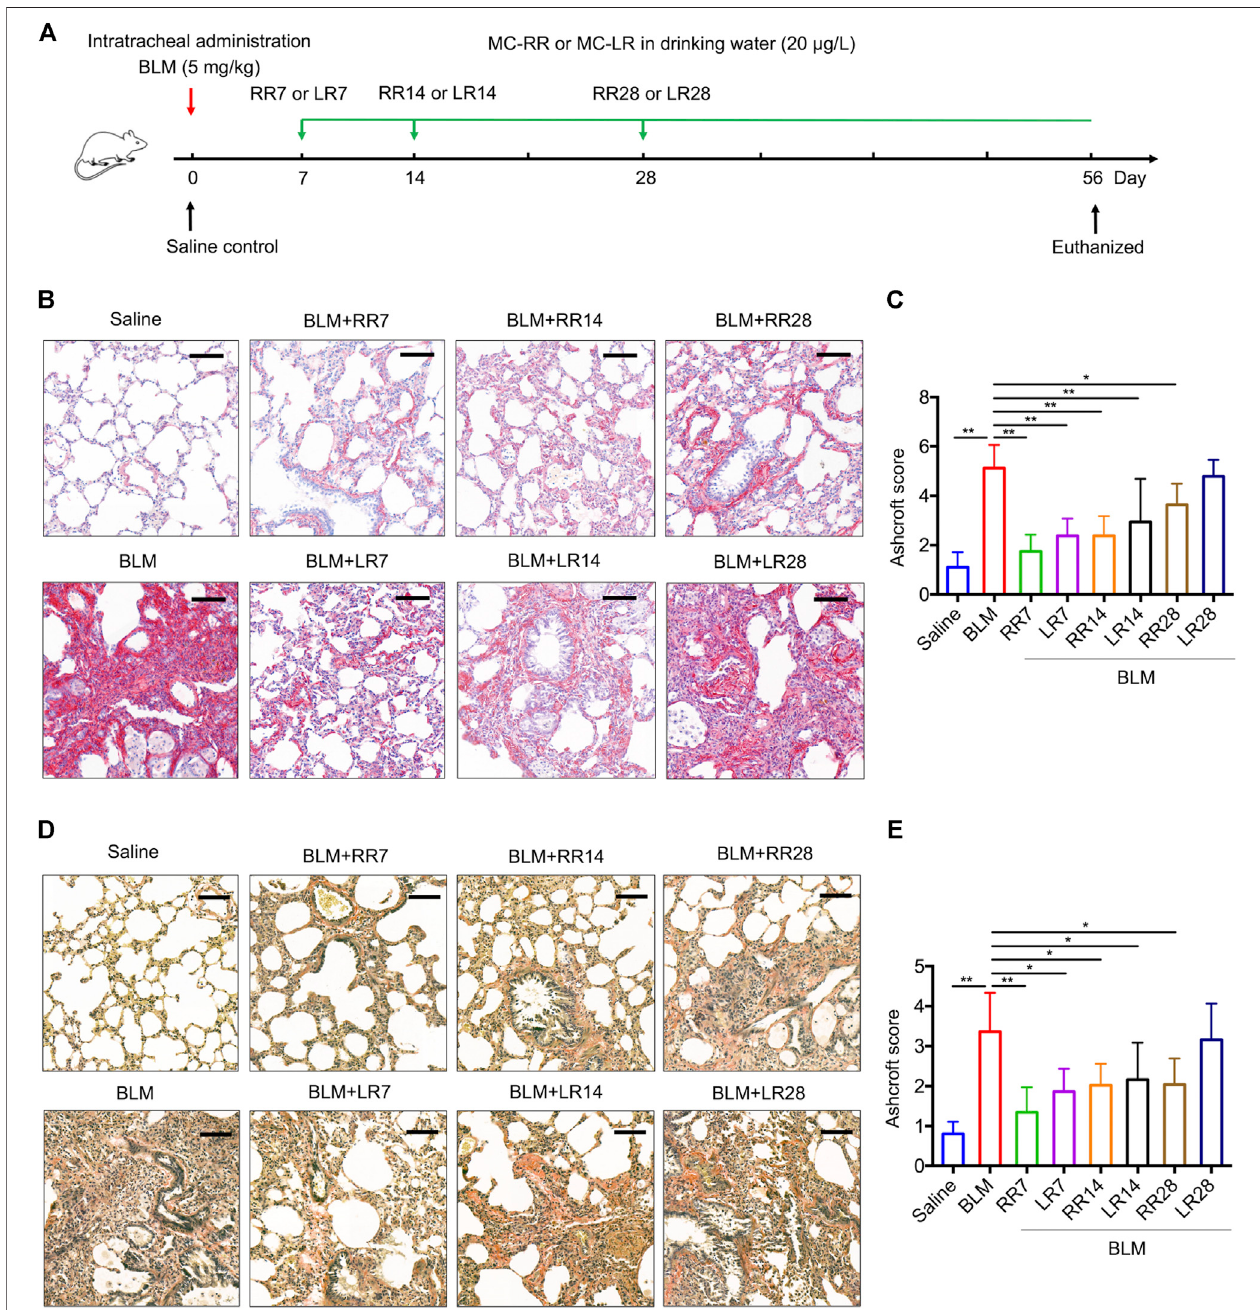
FIGURE 3 | Microcystin-RR (MC-RR) inhibits deposition of collagen and elastic fi bers better than Microcystin-LR (MC-LR). Rats were intratracheally instilled with a single dose of bleomycin (BLM, 5.0 mg/kg) on day 0 and started to receive MC-RR or MC-LR (20 μ g/L) in drinking water on day 7 (LR7/RR7), 14 (LR14/RR14), or 28 (LR28/RR28). On day 56, rats were killed and their lung tissues were collected for analysis. (A) Schematic representation of the experimental design. (B,C) Lung tissue sections were prepared and subjected to Sirius Red staining. Scale bar: 100 μ m. Ashcroft score of stained sections was shown as mean ± SD per group. (D,E) Elastic fi bers of rat lung tissues were evaluated by Van Gieson staining. Scale bar: 100 μ m. Ashcroft score of stained sections was presented as mean ± SD. * p < 0.05, ** p < 0.01 determined by one-way ANOVA with S-N-K post-hoc analysis. Each group had fi ve rats.